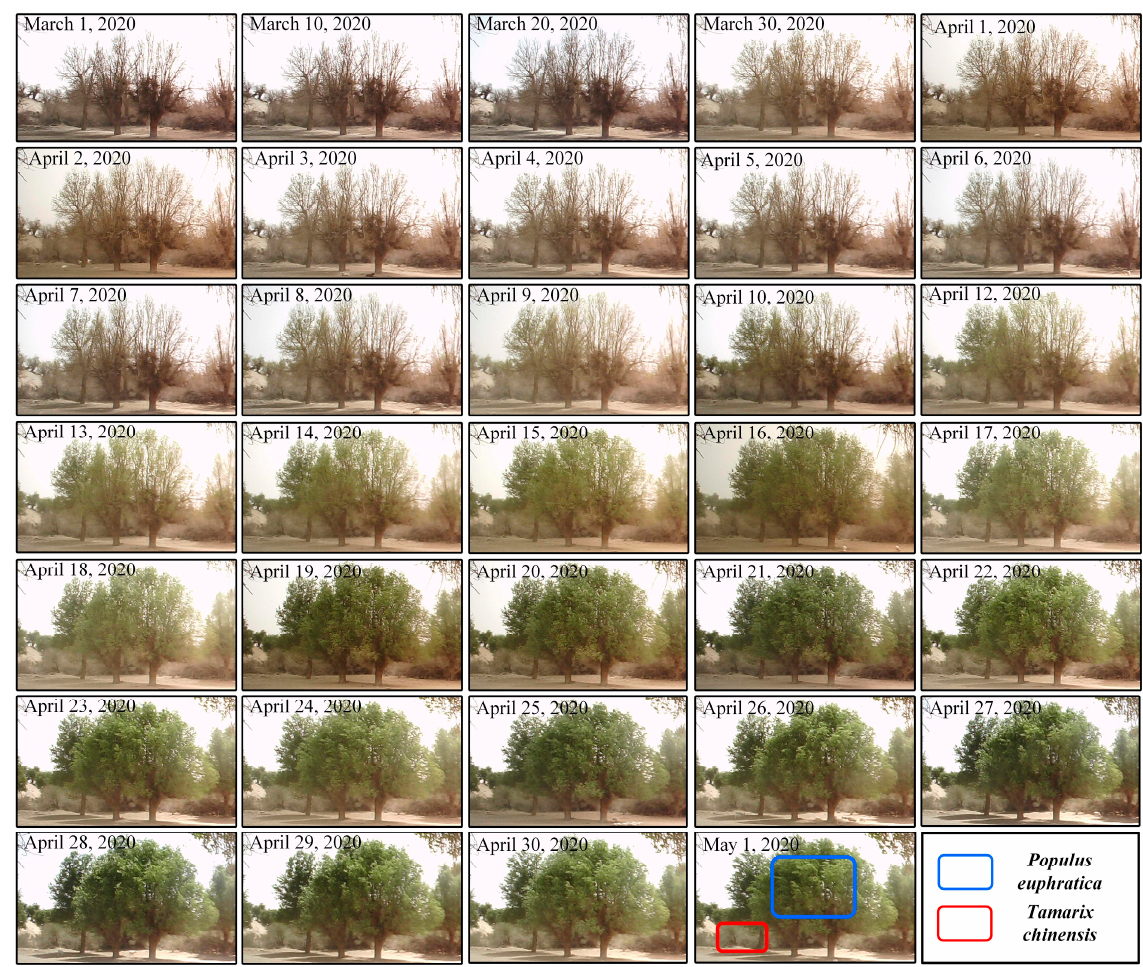
Figure 8. Greenness changes in Populus euphratica and Tamarix chinensis during the leaf development period. From the graphs (Figures 8 and 9), the leaf greening period of Populus euphratica is earlier than that of Tamarix chinensis , and the greening speed of Populus euphratica is significantly faster than that of Tamarix chinensis . Specifically, the Populus euphratica leaves began greening between the end of March and the beginning of April, and greening increased exponentially around 10 April. The greenness approached a peak around 19 April and increased slowly for one week (around 27 April), after which the greenness did not increase significantly. The greenness change of Tamarix chinensis was relatively slow. The greening period of Tamarix chinensis started around 10 April; the greening speed was relatively fast at the beginning of May, reaching its peak around 25 May, after which the greenness did not increase significantly. Overall, the greening period of Tamarix chinensis lagged behind that of Populus euphratica by approximately one month. Comparing the numerical difference between the two curves, the peak difference period in IRECI between Populus euphratica and Tamarix chinensis lasted from 22 April to 1 May 1. We note that, starting from May, sandstorms occurred frequently and visibility decreased, leading to a decrease in the ExGR values in the pictures. The field observation records for Populus euphratica at different growth stages conducted in Alar in the northwestern Tarim Basin revealed that the leaf emergence of Populus euphratica was concentrated in early April, followed by leaf unfolding in mid-April, which lasted to mid–late May [54]. This is consistent with our observations in the Daliyabuyi